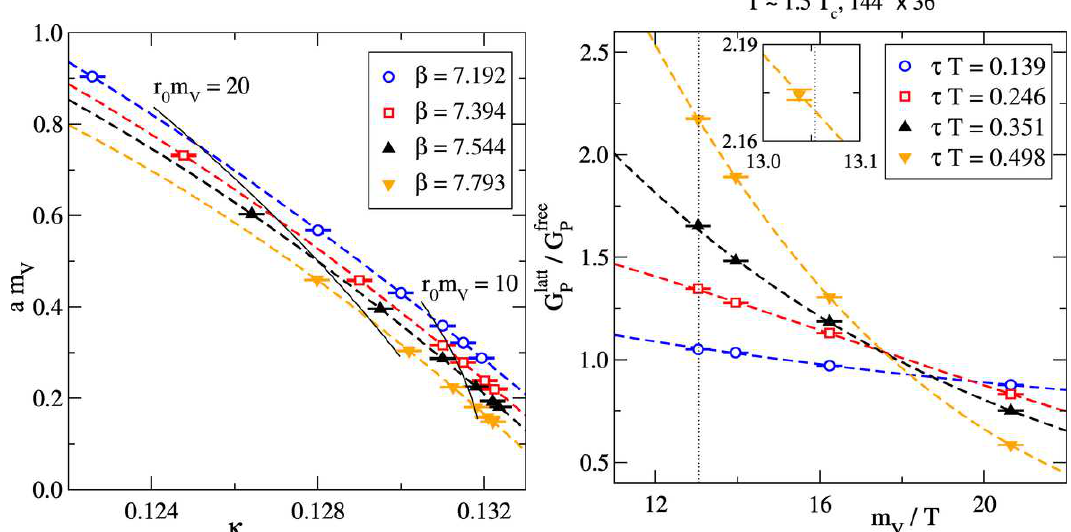
Figure 2 . Left: The vector meson (physically J/ψ, Υ) masses in lattice units, am , measured from V spatial correlators deep in the confined phase. Dashed lines show quadratic fits, meant to guide the eye. Solid lines show “lines of constant physics”, with the conversion of a to physical units being based on r , cf. table 2 ( r m = 20 corresponds to m 8 GeV, r m = 10 to m 4 GeV). 0 0 0 V V ≃ V V ≃ Right: An example of an interpolation of the thermal correlator to a physical mass value (in this case m 3 . 1 GeV, indicated by a dotted line). Units are again converted via r 0 . 47 fm [50]. 0 ≈ J/ψ ≈ a narrower resonance, however in practice this difference is inessential on our